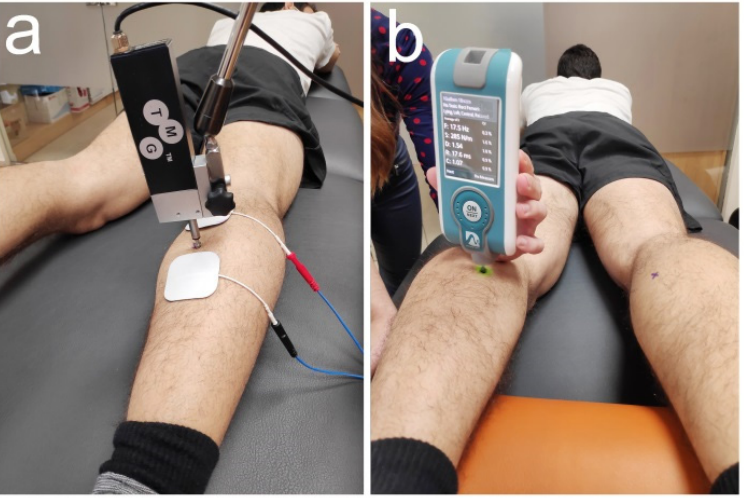
Figure 1. ( a ) Tensiomyography; ( b )